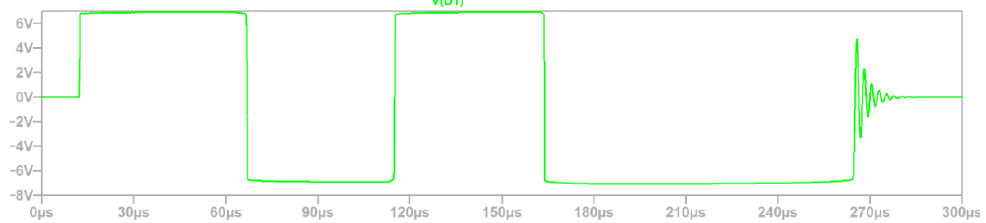
Figure 12. Voltage waveforms of D1. Table 5. GA parameters and result comparison.